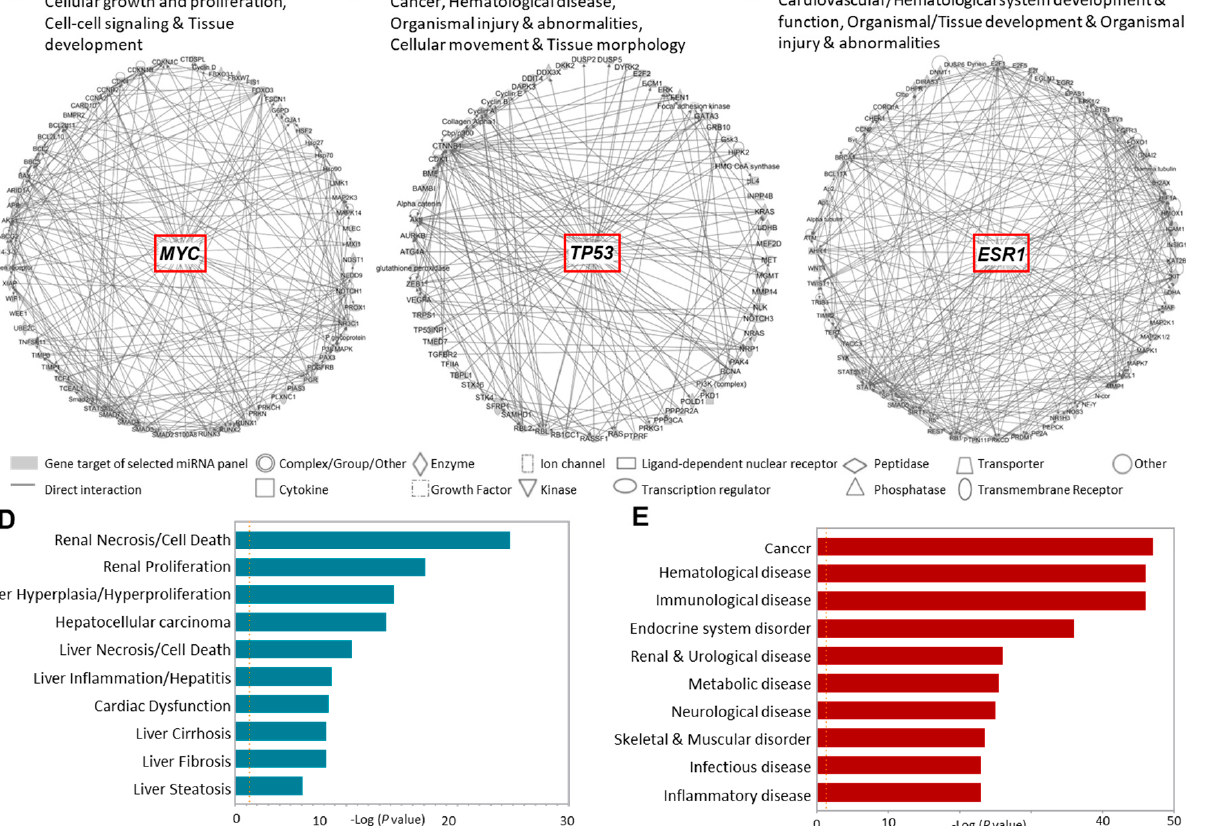
Figure 5. Disease annotation and Ingenuity pathway analysis for the gene targets of dysregulated miRNAs in AIS versus TIA patients. The gene targets of the 11 dysregulated miRNAs in AIS compared to TIA patients were analyzed for disease/function annotation and network analysis. ( A – C ). Ingenuity pathway network analysis of the gene targets of dysregulated miRNAs in AIS patients are shown. ( D – E ). Bar plots show the clinical pathology endpoints and diseases annotations associated with these genes.